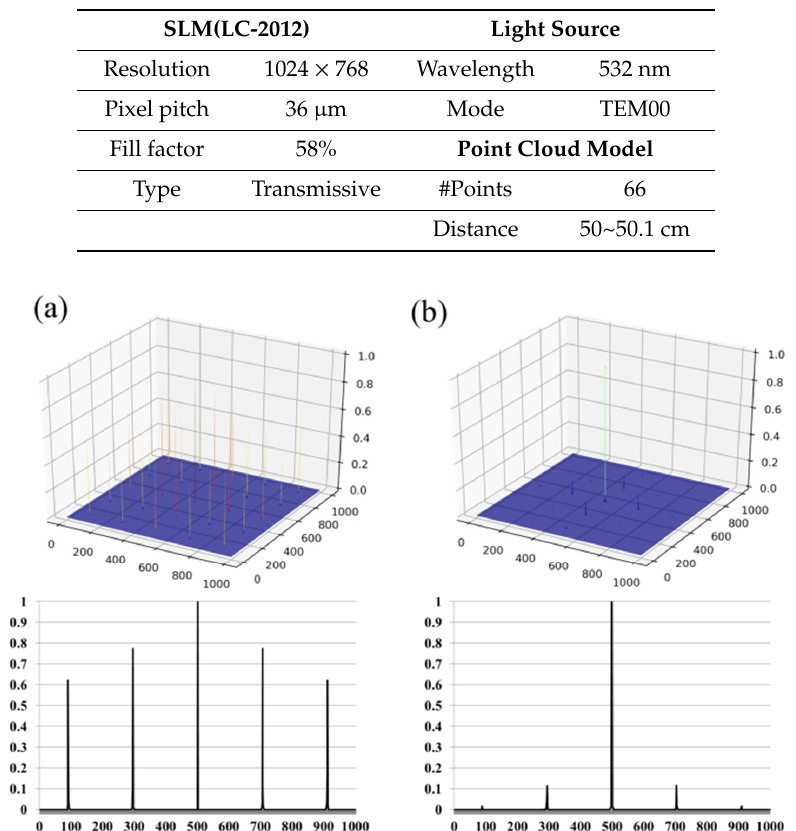
Figure 3. Numerical simulation of a single-point hologram with ( a ) conventional periodic pixels and ( b ) fully non-periodic pixels. ( b ) fully non-periodic